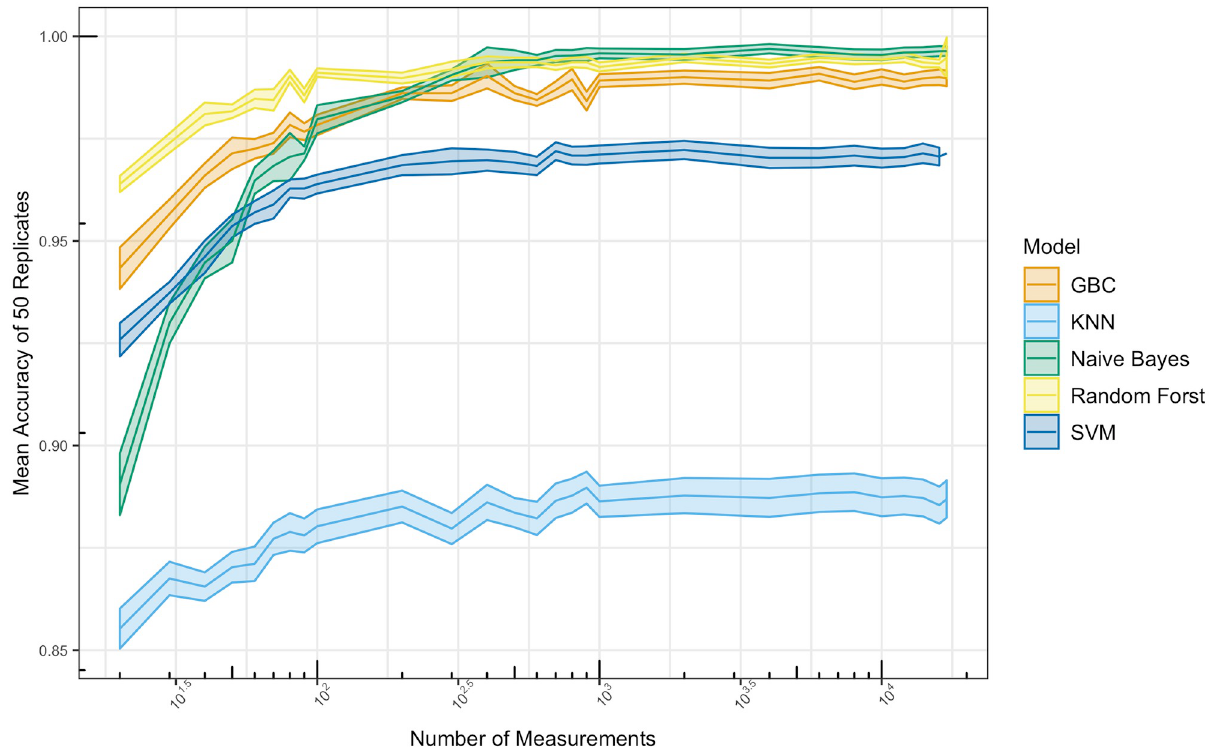
Fig 4. Classification accuracy vs number of features. The original 17,156 CNA measurements in the imputed dataset were randomly downsampled incrementally from 17,000 to 10 and converted to digit-frequency training and test features for machine learning models. When 1,000+ measurements are used in the creation of digit-frequencies features, there appears to be little to no effect on mean accuracy. Once the number of features drops below 300 all models begin to lose accuracy rapidly. RF remained above 97.5% accuracy until less than 30 measurements were